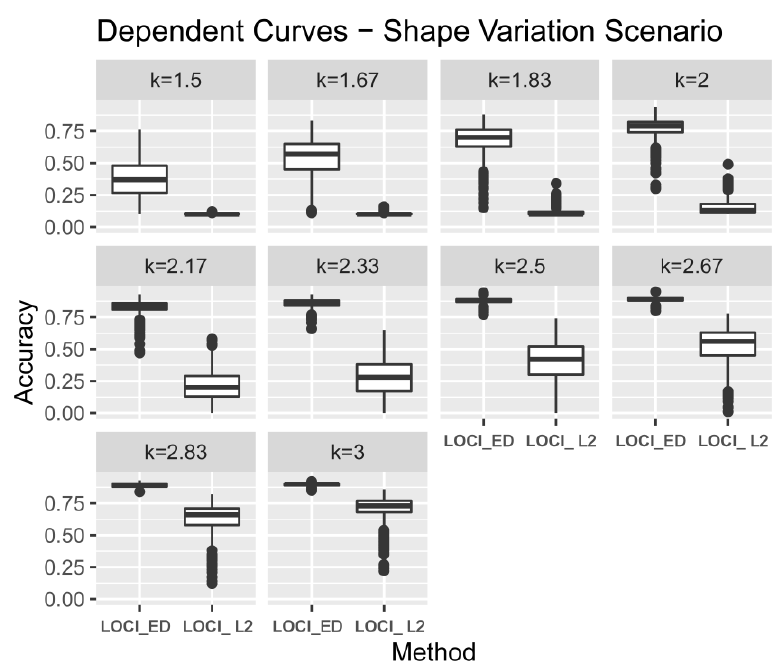
Figure 3. Accuracy corresponding to the FD-LOCI method with L2 and elastic distance, respectively. The simulation scenario is defined by dependent curves ( 𝜌 = 0.7 ) and the presence of anomalies in shape ( 𝜂 = 1 ).